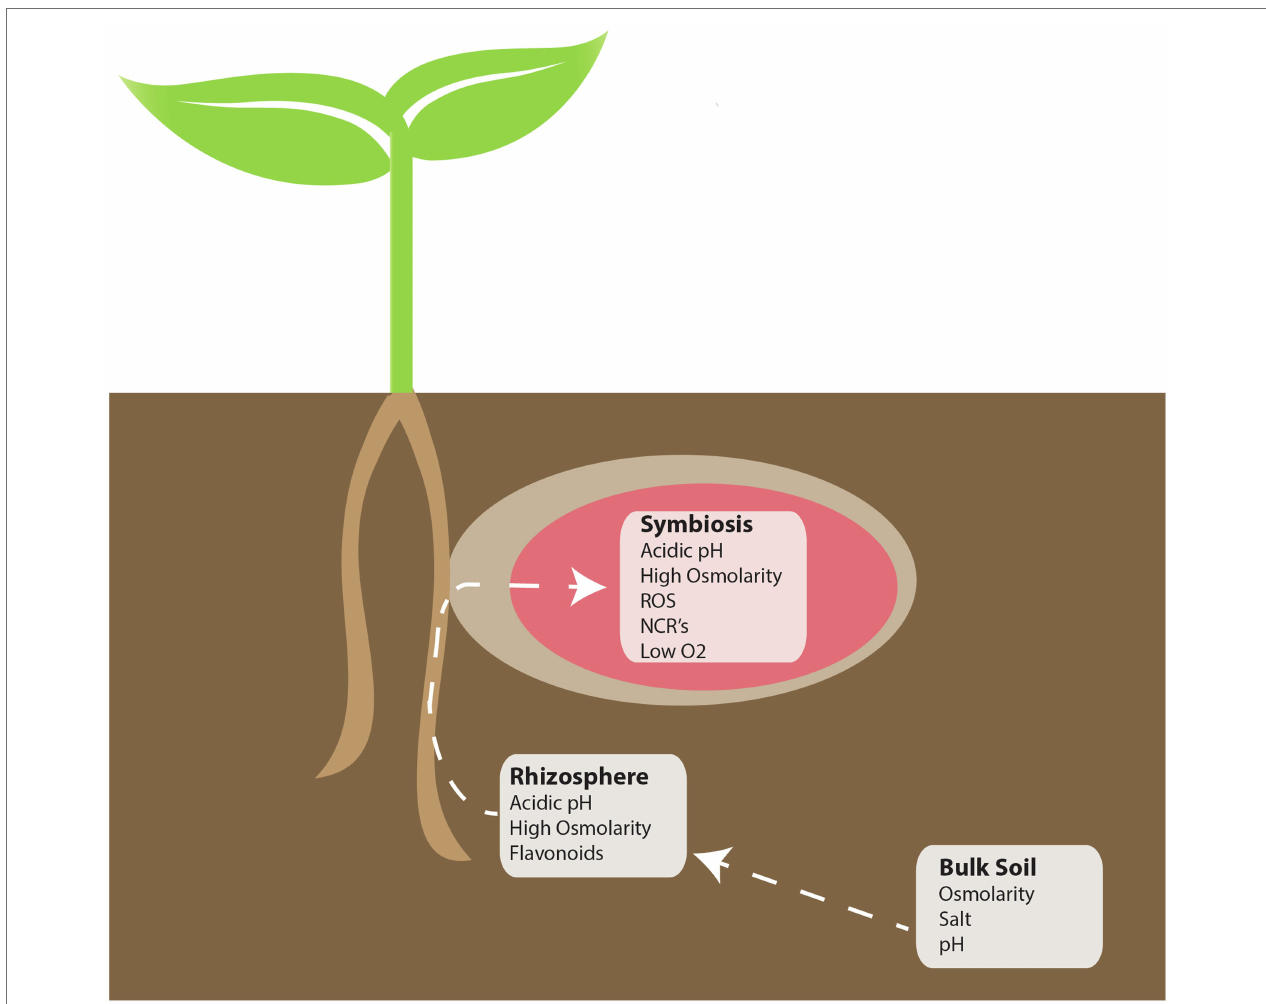
FIGURE 1 | Locations of perceived stress during the rhizobia-legume symbiosis. During symbiosis, there are three distinct environments that symbiotic bacteria must contend with: Bulk soil, the rhizosphere, and in planta . Each white box indicates potential “perceived” stressors that may be encountered in each of the indicated